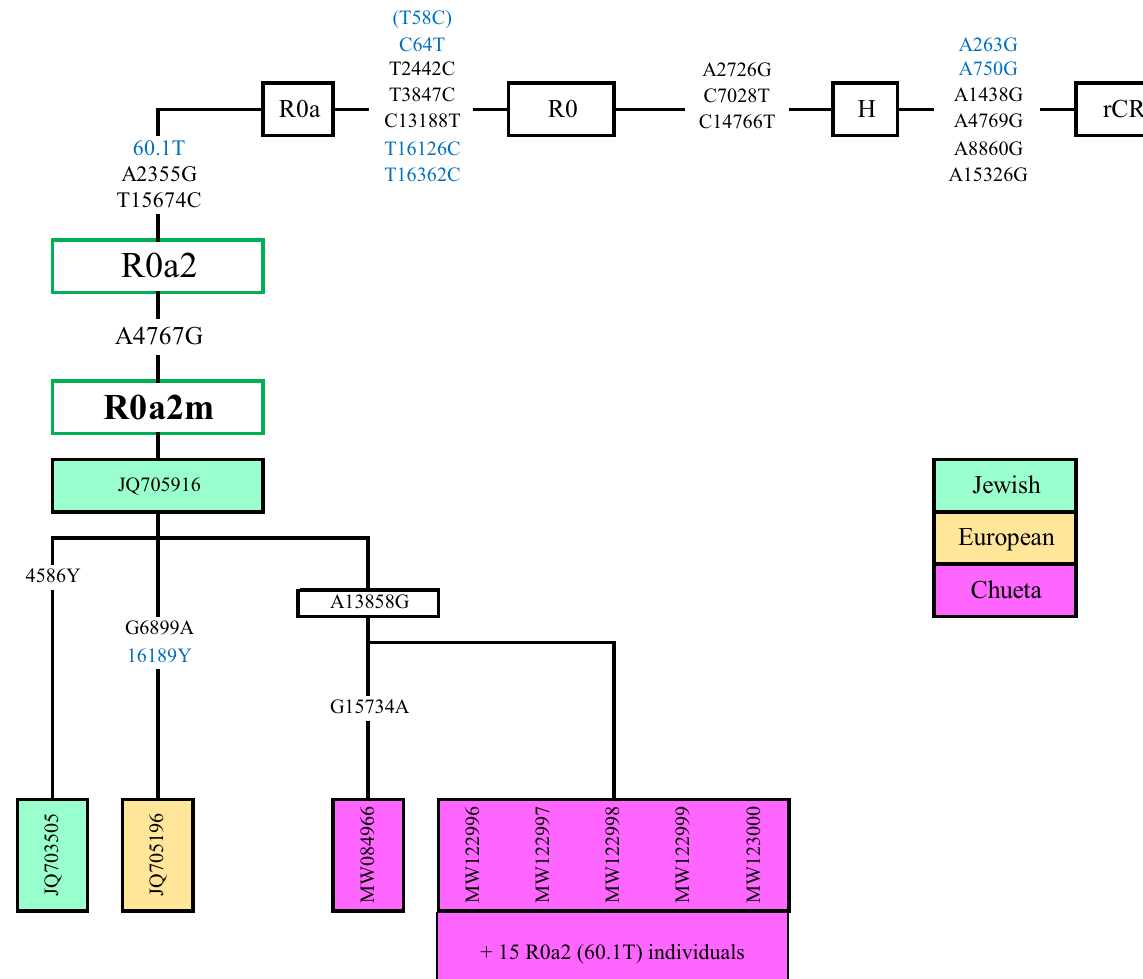
Figure 6. Phylogenetic tree of the completed mtDNA sequences belonging to haplogroup R0a2m. Mutations relative to the revised Cambridge Reference Sequence (rCRS) (NC_012920) are shown. Mutations coloured in blue correspond to the D-loop. The origin of the samples in the haplogroup are labelled in colours. In green, two Jewish samples from the Czech Republic and Ukraine (JQ705916 and JQ705196); and in yellow, one sample from Poland with unknown ethnicity (JQ703505). Finally, Chueta samples, with their corresponding GenBank accession numbers, are labelled in pink. The remaining 15 R0a + 60.1 T Chueta samples were found to be R0a2m (A4767G). Presence of the A13858G mutation was confirmed in all, whereas the G15734A mutation remained as a private variant of the MW084966